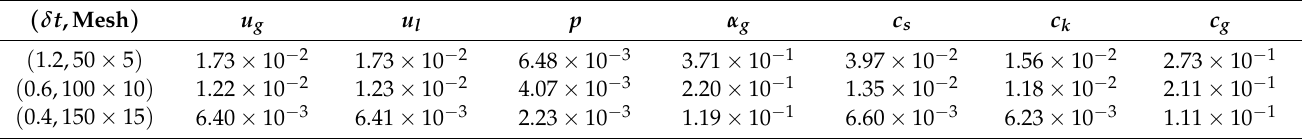
Figure 10. Convergence with respect to δ t and mesh size for the case described in Section 5.2 (see Table 5 for the time step and mesh size pair): log–log plot of the error for each unknown (note that the curves for u g and c k overlap and the curve of u l is closed to them). Table 6. L 2 error with respect to the reference solution provided with time step δ t = 0.3, 200 × 20 uniform mesh, and α = 0.0005 for numerical simulation in Section 5.2 at T =